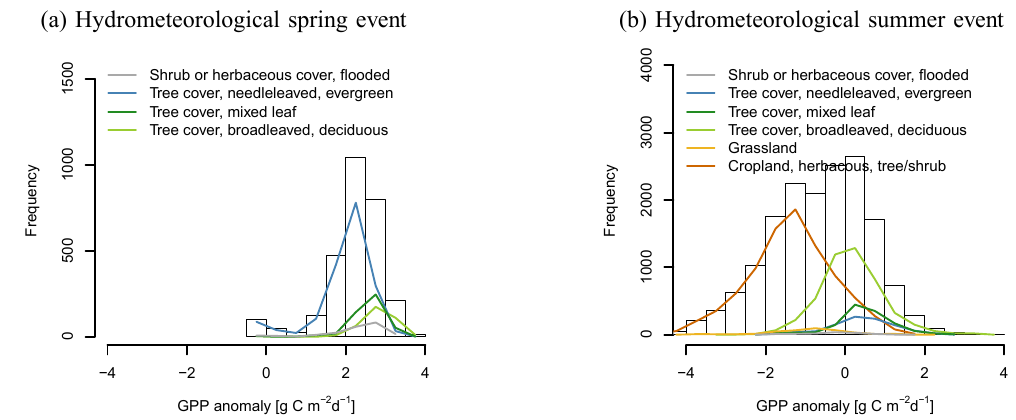
Figure 6. Histogram of GPP anomalies (reference period: 2001–2011) for different land cover classes based on the spatiotemporal extent of (a) the hydrometeorological spring event and (b) the hydrometeorological summer event. Bars denote the sum of all vegetation classes.